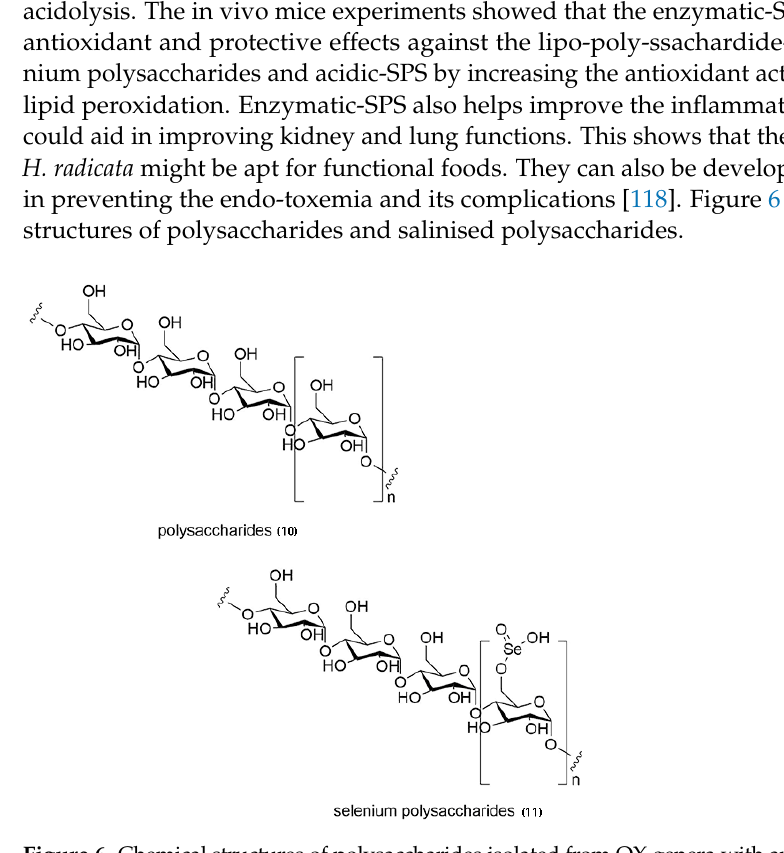
Figure 6. Chemical structures of polysaccharides isolated from OX genera with anti-oxidative properties.